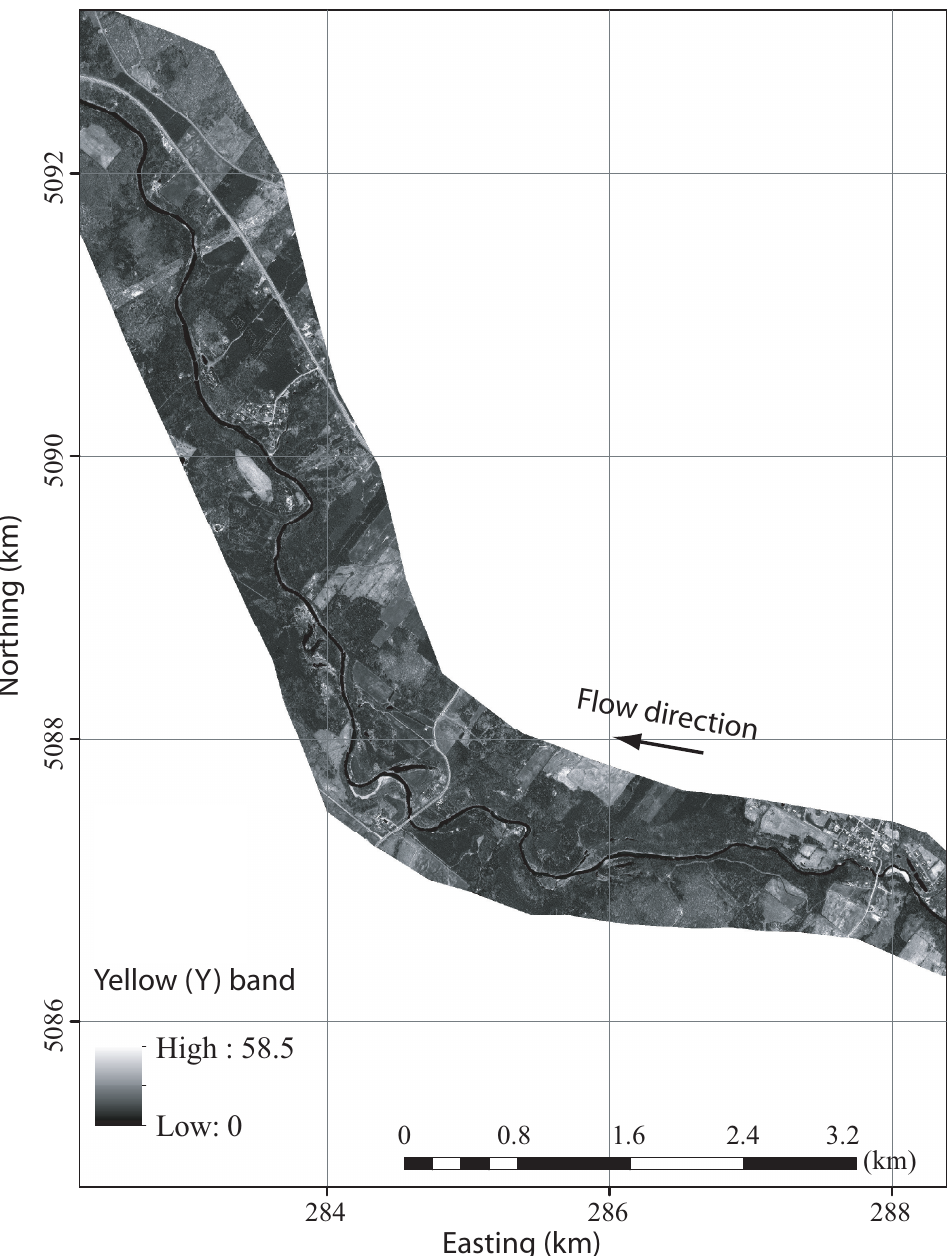
Figure A7. Corrected radiance in the yellow (Y)